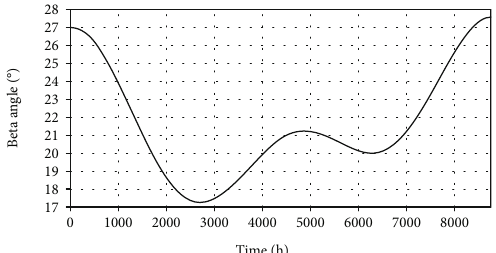
Figure 3: Beta angles within one year.